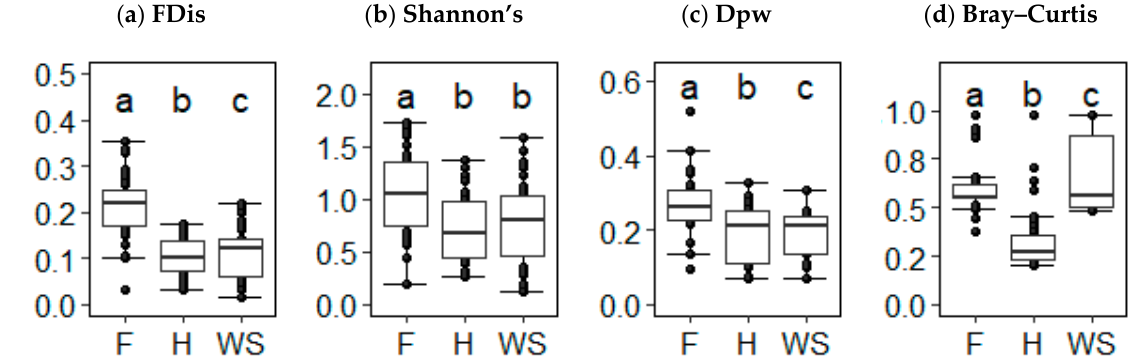
Figure 5. ( a ) Functional alpha diversity (functional dispersion), ( b ) taxonomic alpha diversity (Shannon’s diversity), ( c ) functional beta diversity (functional pairwise dissimilarity), and ( d ) taxonomic beta diversity (Bray–Curtis dissimilarity) values for shrubs in forest (F) ( n = 40), heath (H) ( n = 45), and wood savannah (WS) ( n = 45) alternate states. Unlike letters above the error bars indicate significant differences at p < 0.05.